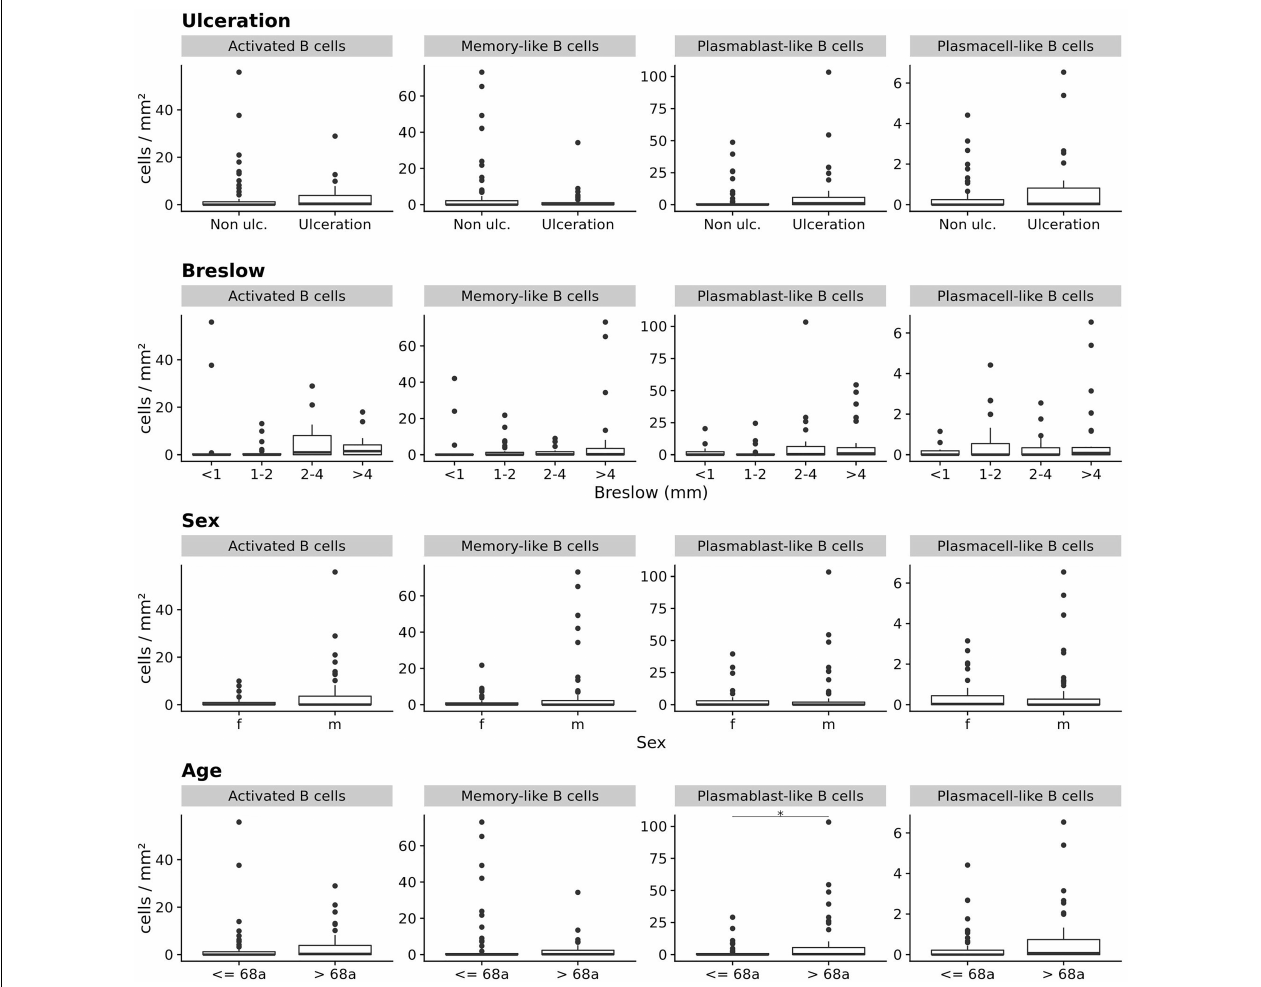
FIGURE 3 | The frequencies (cells/mm 2 ) of four different TAB and ASC subpopulations in primary human melanomas and their association with categorial prognostic clinicopathologic parameters. Box plots comparing primary tumors with and without ulceration, with increasing Breslow depths, for sex and age (from top to bottom). FDR is 0.05 for plasmablast-like ASC and age (median = 68 years). In boxplots lower and upper hinges correspond to first and third quartiles and center lines to medians. Upper whiskers extend to the largest value within 1.5 times the interquartile range. Outliers are shown as black circles. * p ≤